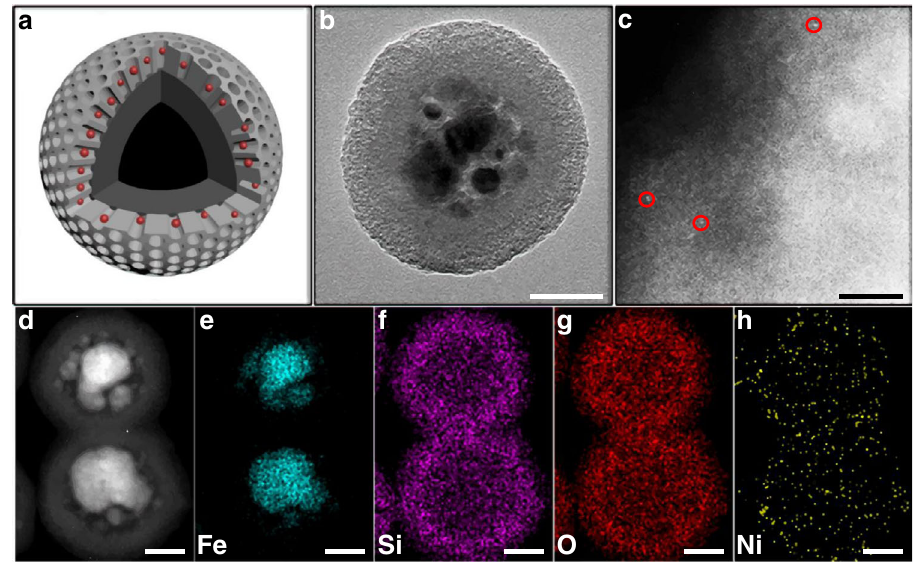
Fig. 2 | Morphology and components of the carefully designed S Fe-Ni catalyst. a Schematic of S Fe-Ni . The black core, the dark gray middle layer, the light gray porous outer layer and the red spheres represent CNC, the dense silica, the